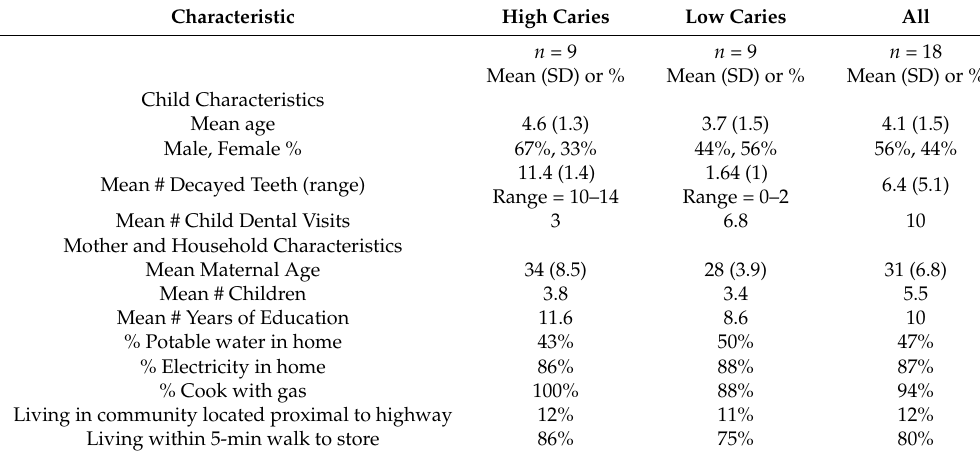
Table 1. Child Dental Status and Family